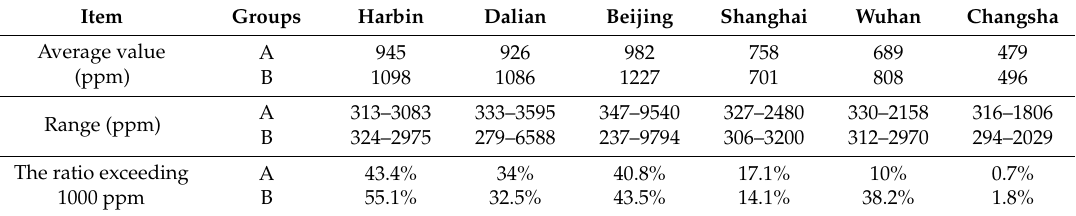
Table 3. Indoor CO 2 concentration in different cities in